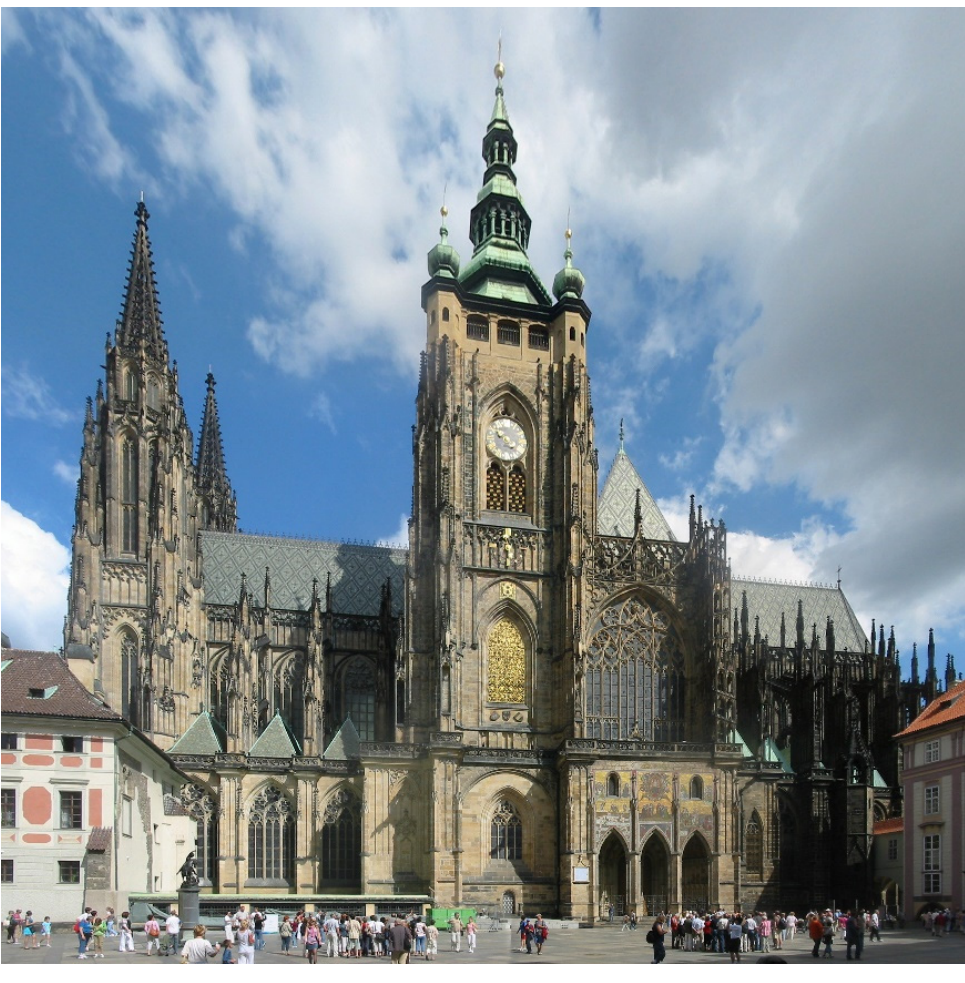
Figure 1. St. Vitus Cathedral [4].